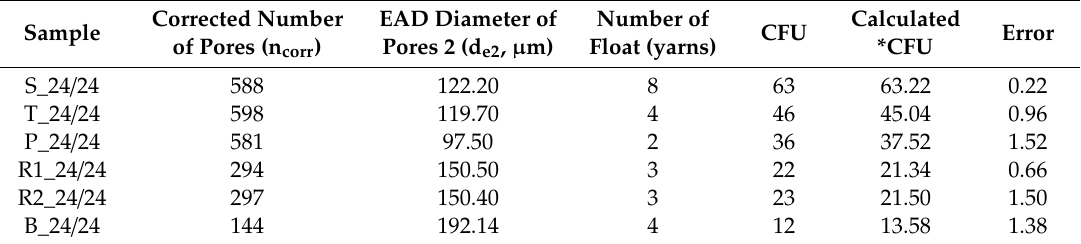
Table 8. Multiple linear regression of fabric samples with a density of 24 / 24.